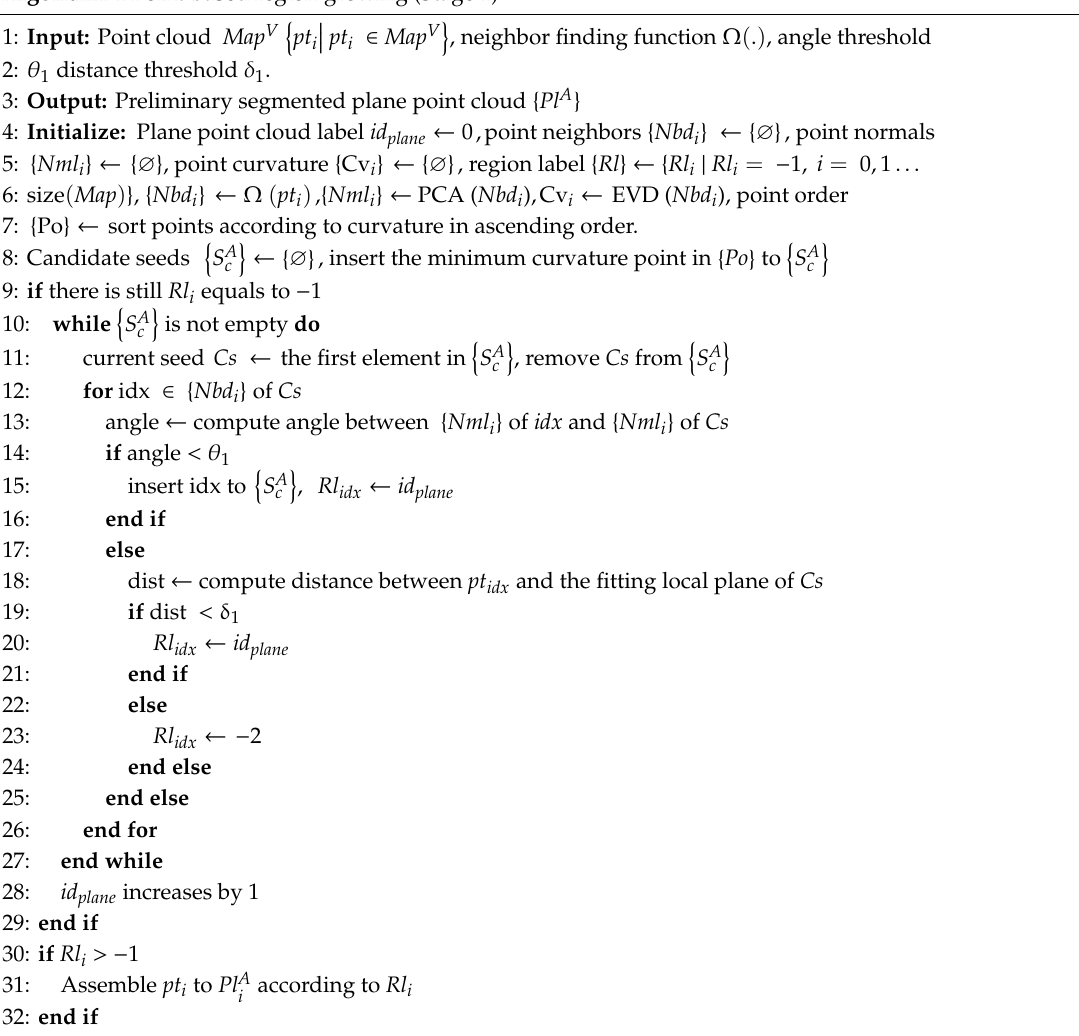
Algorithm 1 Point-based region growing (Stage